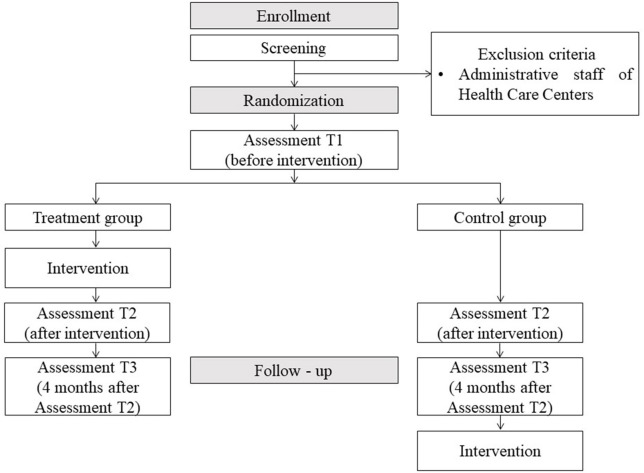
Study flowchart.